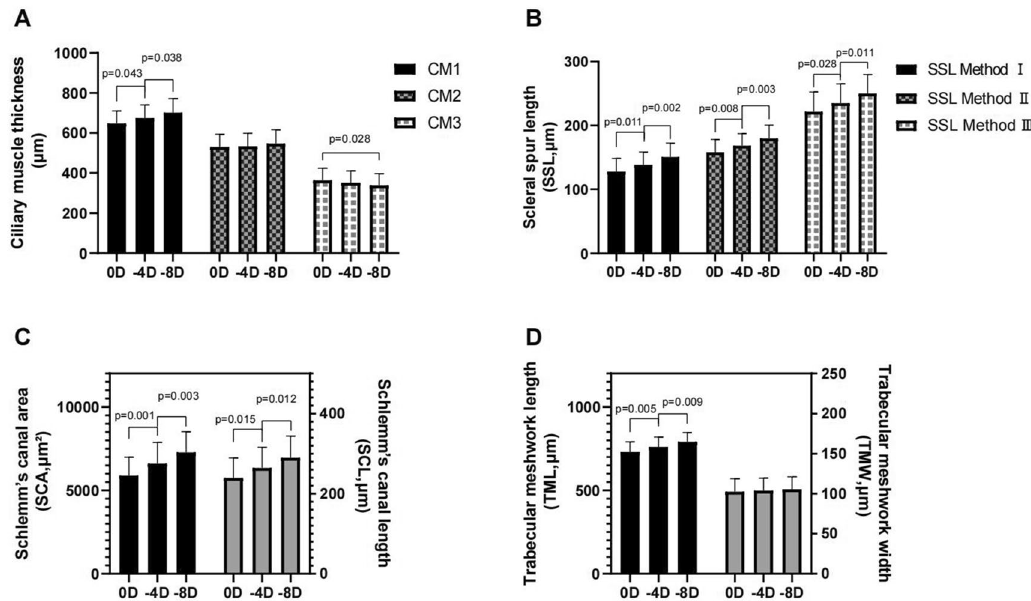
Figure 4. ( A ) CM1 increased significantly with accommodation state. CM2 did not change significantly. Compared to the base state, CM3 decreased at -8D accommodation state. ( B ) SSL that was measured by three different methods increased with accommodation stimulation. ( C ) SCA and SCL increased significantly with accommodation stimulation. ( D ) TML increased significantly with accommodation stimulation, but TMW did not.